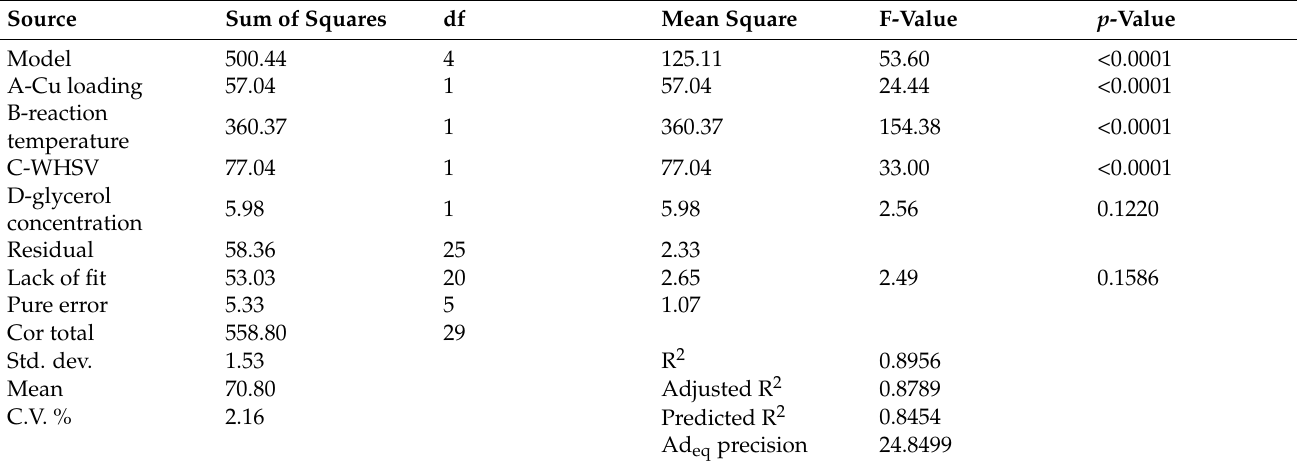
Table 4. Analysis of variance (ANOVA) for response surface of linear model for Equation